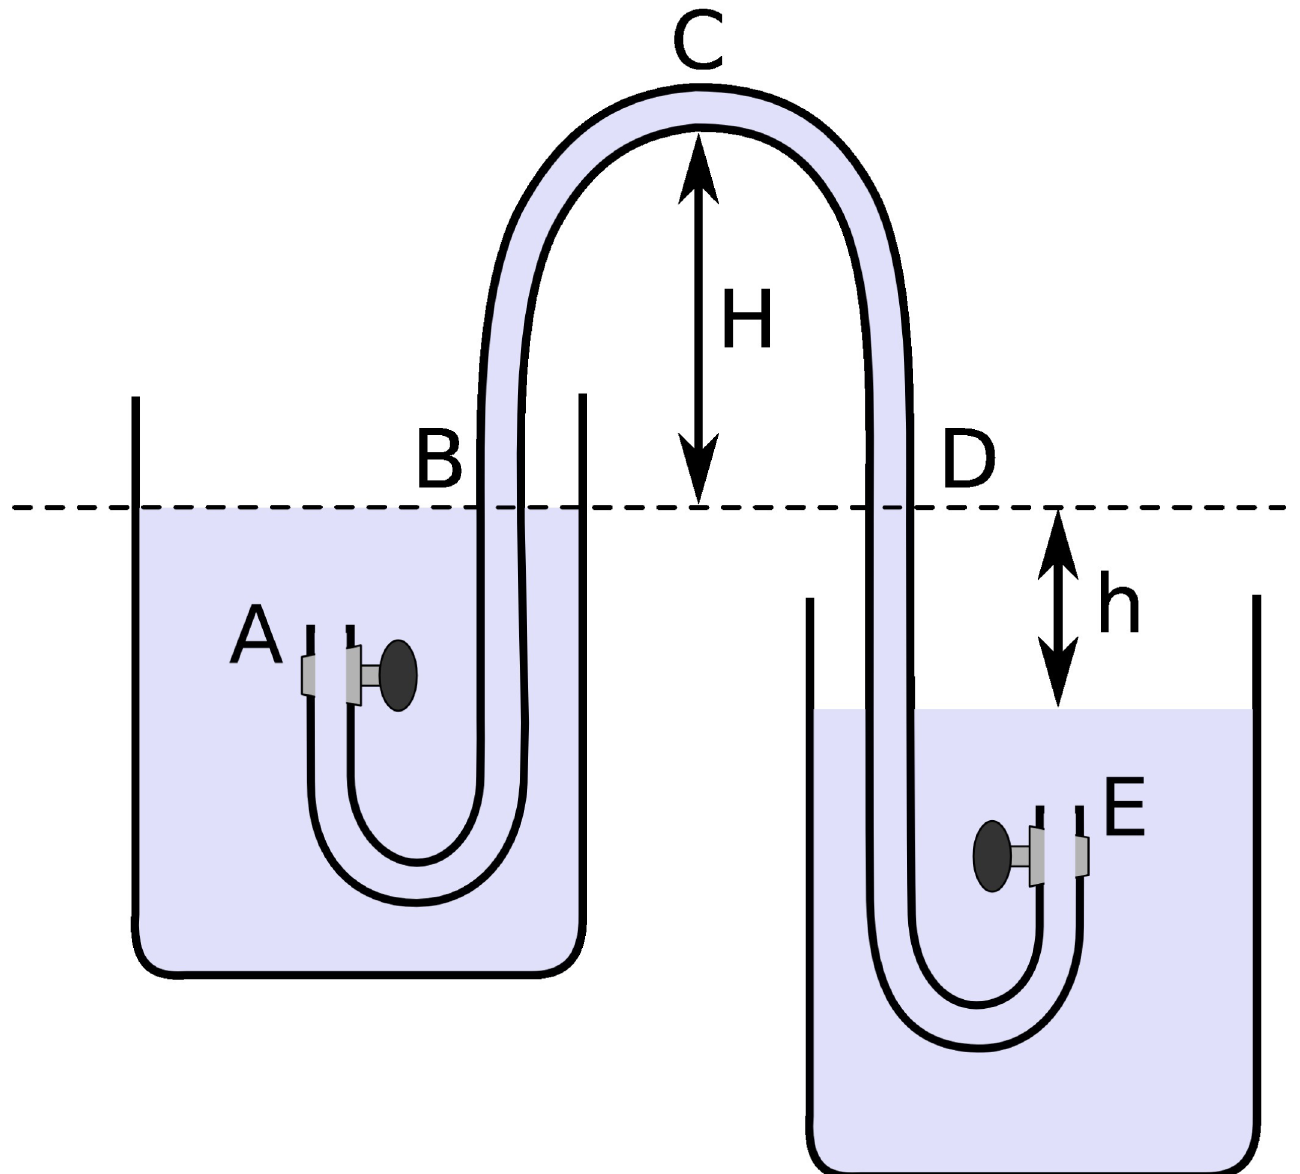
Fig 2. Diagram of the setup for the siphon used in our